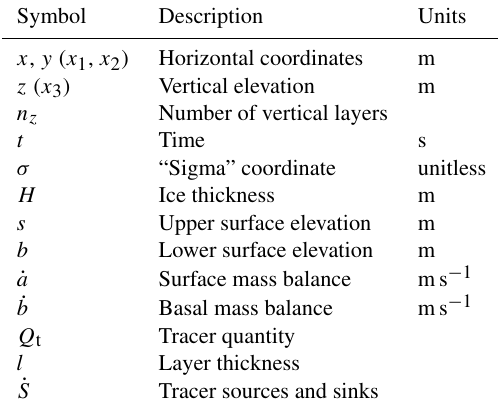
Table A2. General variables and